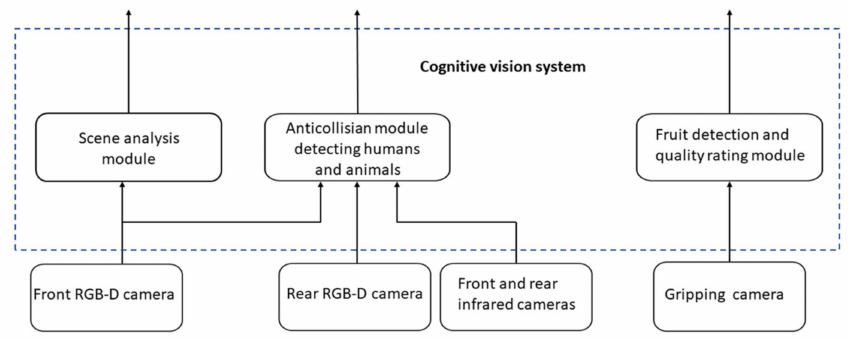
Figure 11. The structure of the cognitive vision